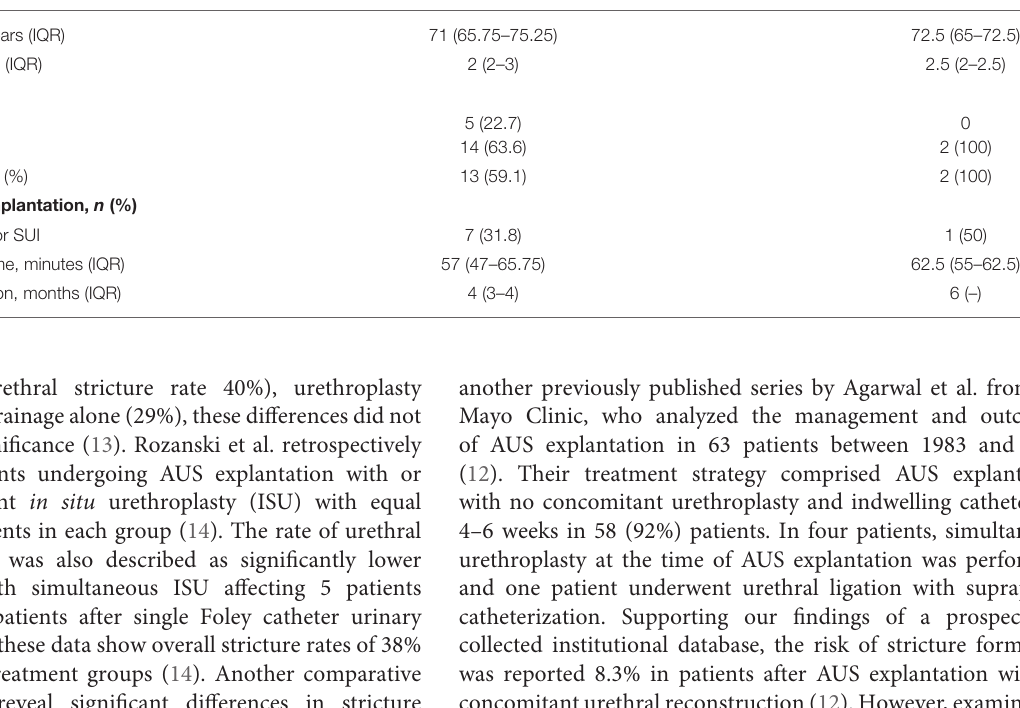
TABLE 2 | Clinical characteristics among patients stratified to the presence of stricture formation after AUS explantation due to erosion. Patients, n